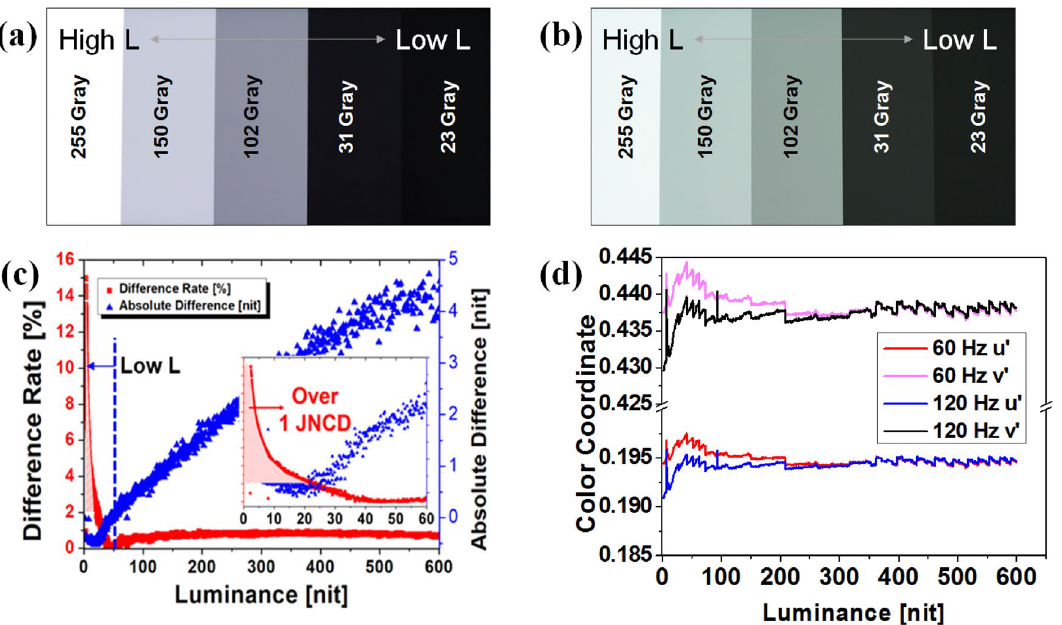
Figure 1. T the gamma scale for frequencies of ( a ) 60 Hz, and ( b ) 120 Hz, without compensation. The differences in ( c ) luminance and ( d ) color, between frequencies of 60 Hz and 120